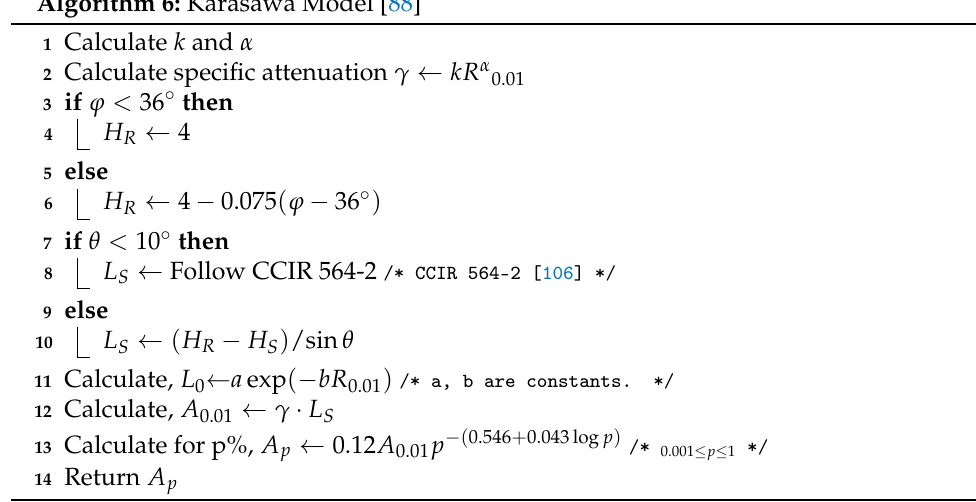
Algorithm 6: Karasawa Model